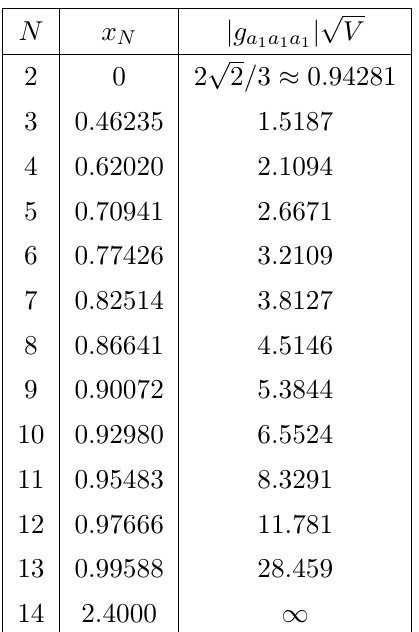
=(cid:21) a for closed Einstein manifolds 1 1